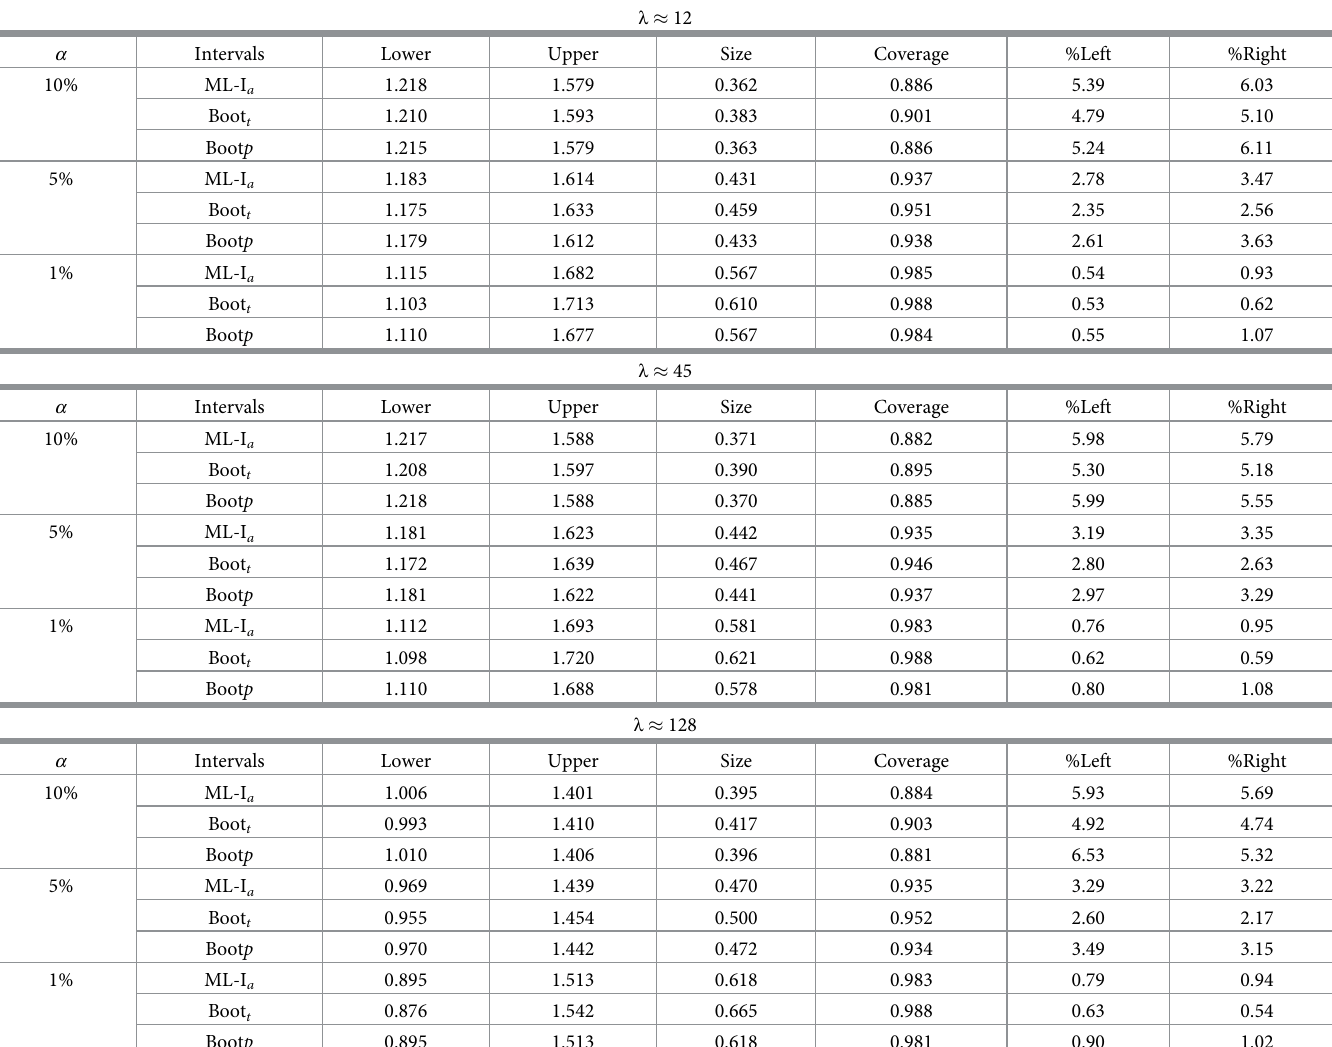
= 1 (cid:0) μ Þ ¼ β þ x β 2 þ β þ β and log ð σ 2 Þ ¼ γ þ z γ 2 , t = 1, ... , n , μ t 2 (0.02, 0.32), β 2 = 1.2, n = x x t t 2 t t 1 3 t 3 4 t 4 1 t